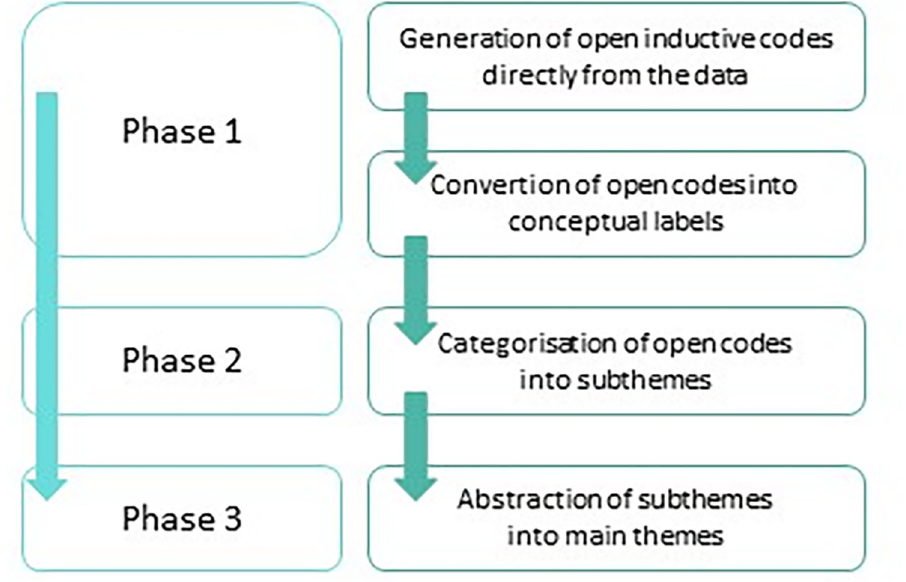
Fig 1. Phases of inductive content